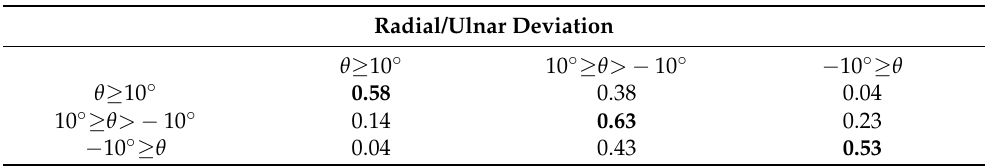
Table 2. Contingency table of cumulative model performance in radial/ulnar deviation with the true posture shown vertically and predicted posture